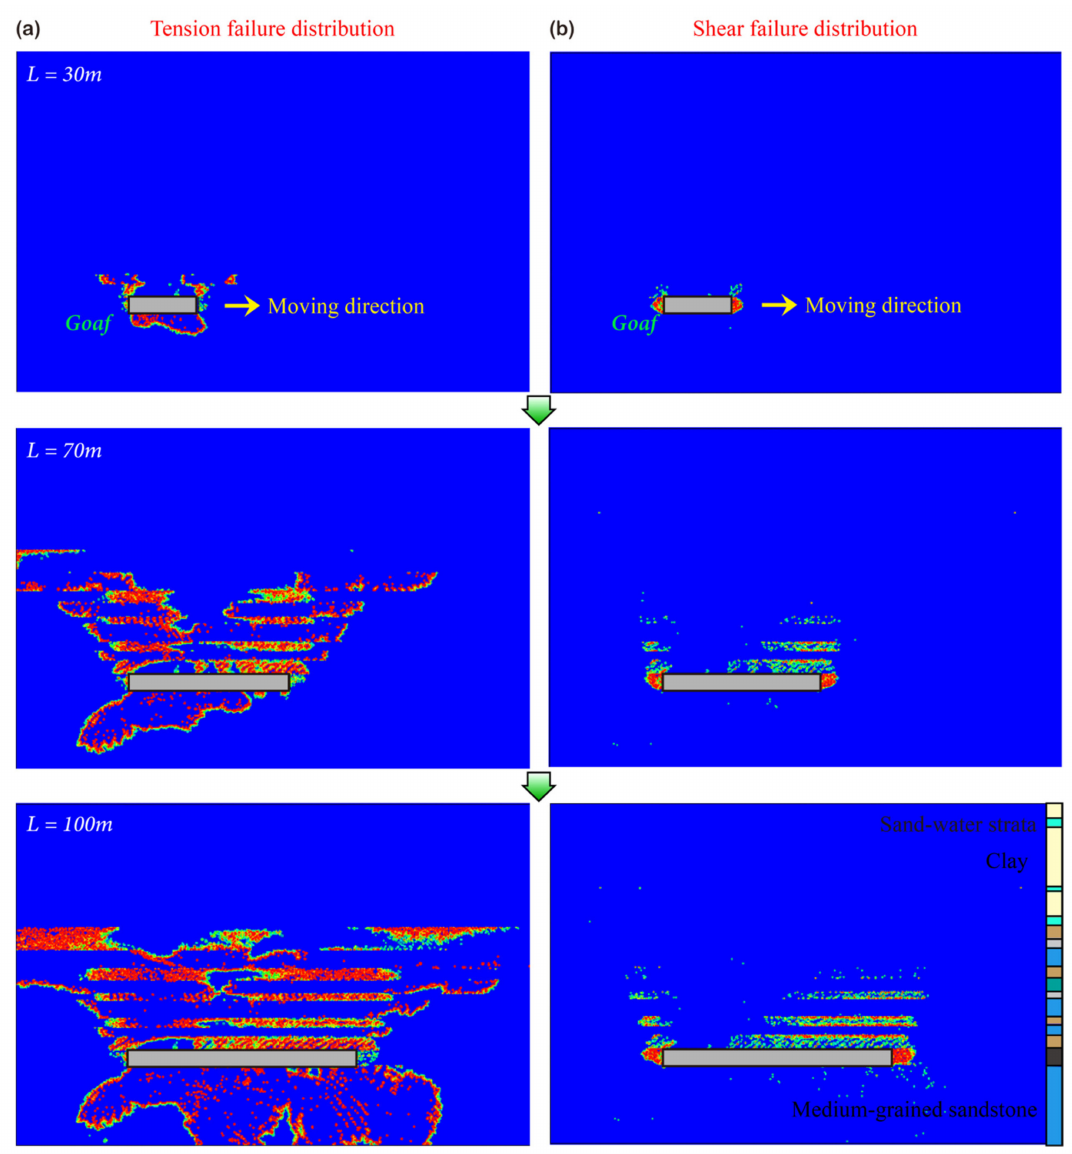
Figure 4. Distribution of tension and shear fracture zones in the process of overburden fracture and collapse: ( a ) tension failure distribution; ( b ) shear failure distribution.